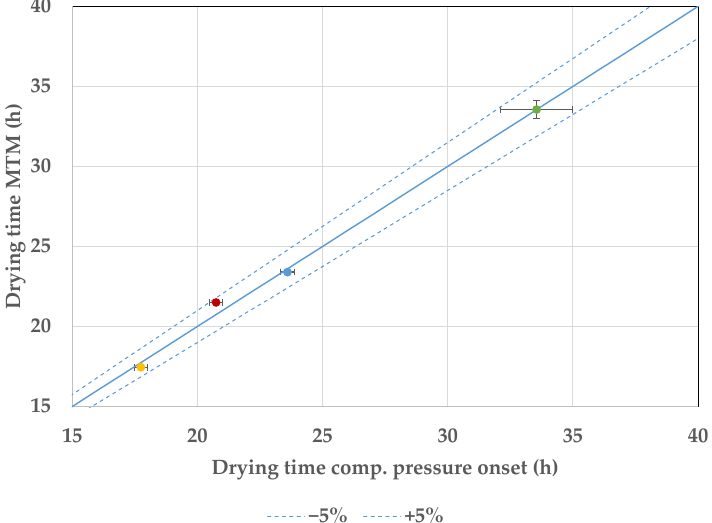
Figure 9. Comparison of primary drying endpoint of MTM and comparative pressure measurement onset (red: + − , yellow: ++, blue: CP, green: −− ).